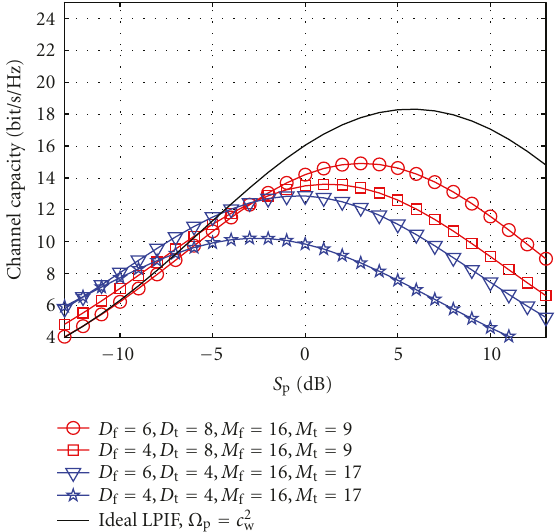
Figure 7: Capacity versus pilot boost for 8 × 8 MIMO-OFDM sys- tem with di ff erent pilot grids at an SNR of γ